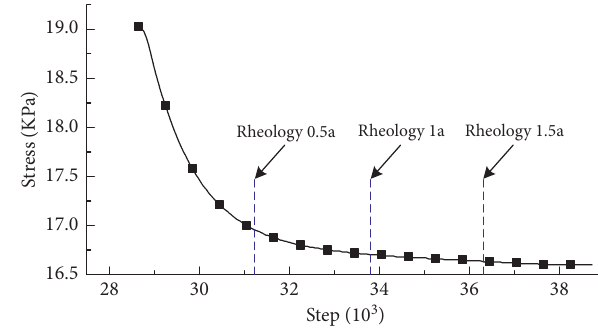
Figure 13: Support pressure evolution curve.